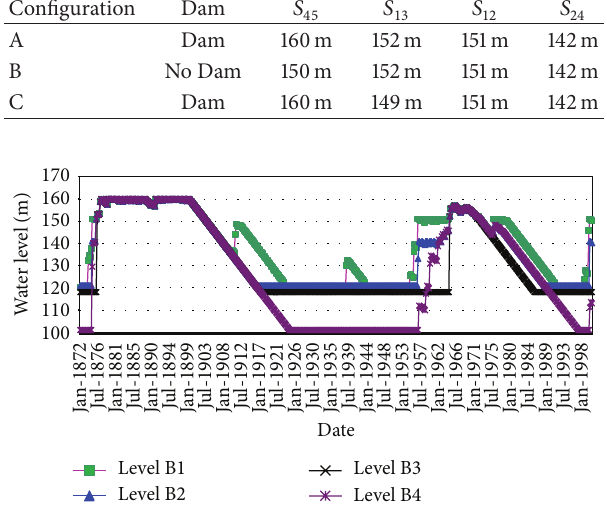
Figure 10: Water level time series for TD configuration A.